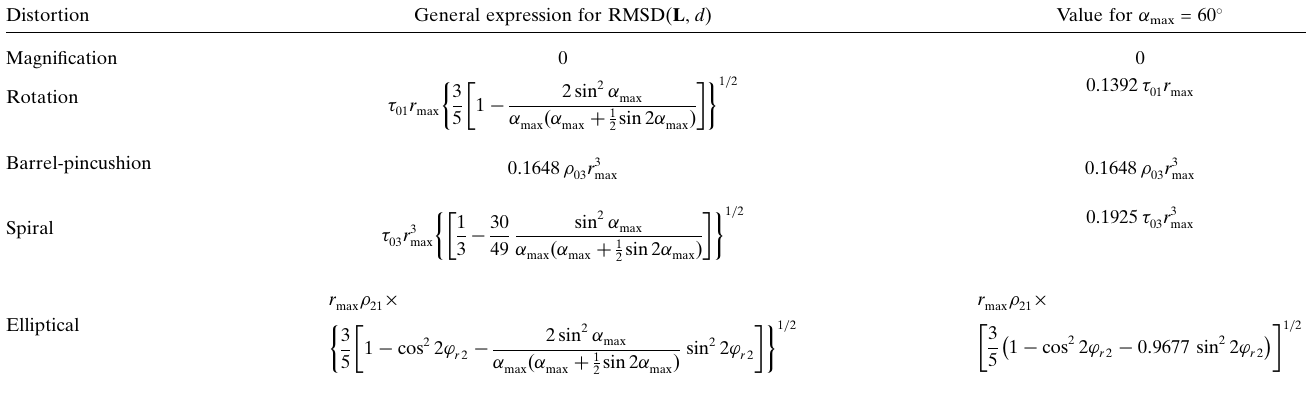
Table 4 Root-mean-square deviations RMSD( L , d ) for individual standard distortions. Distortion General expression for RMSD( L , d )